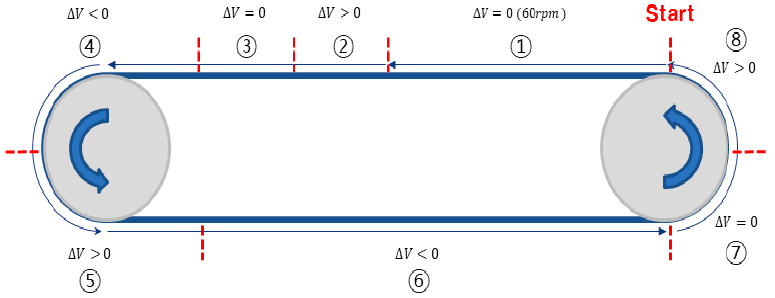
Figure 3. Changes in sectional velocity in the gutting section of the SBOGM.